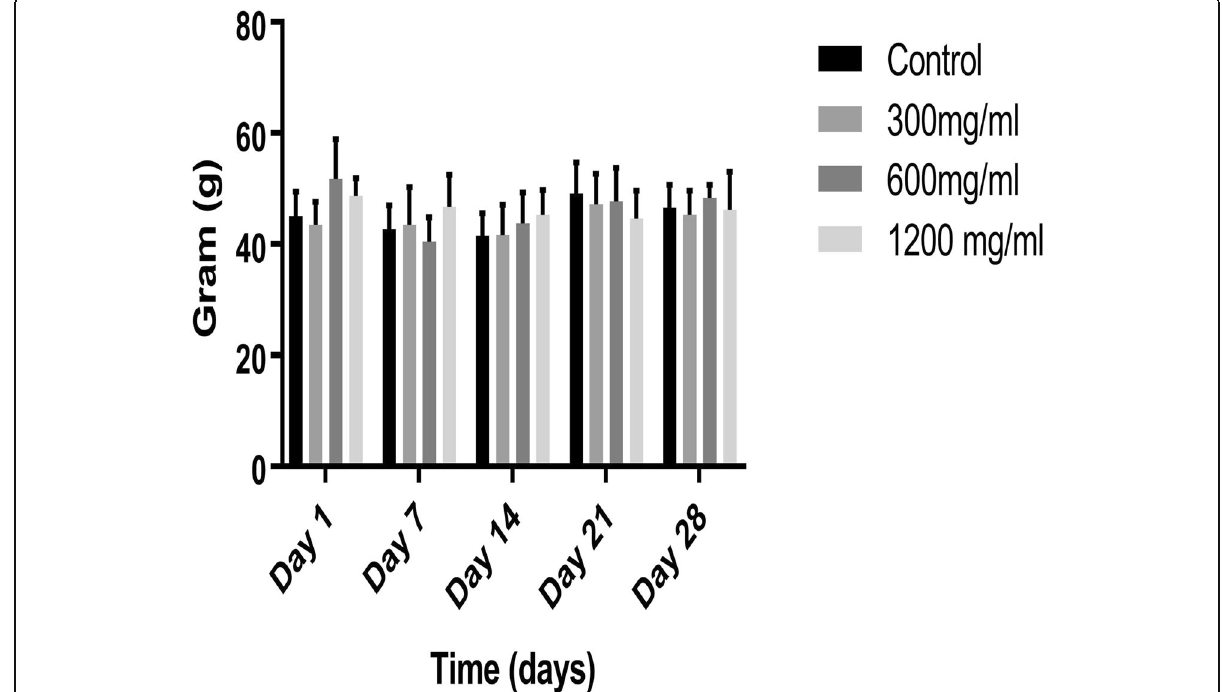
Fig. 6 Effect of STRE on food intake of female subjects. Values are expressed as mean ± SEM Statistical significance (p) calculated by one way ANOVA followed by dunnett ’ s ( n =